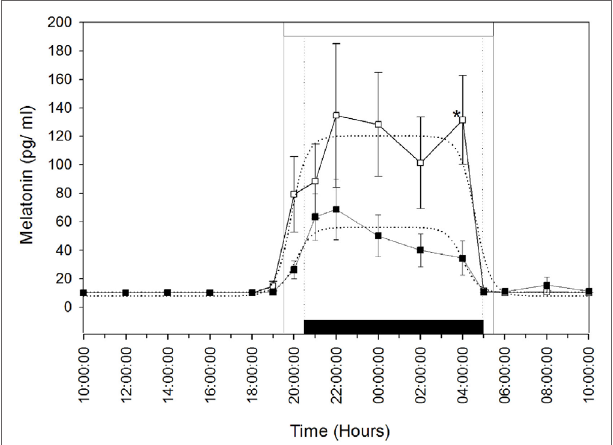
FigUre 2 | Comparison of plasma melatonin concentrations in melatonin-treated group ( ◾ ) and the control group ( ◽ ). (a) Day time plasma melatonin concentrations (mean ± SEM) before and after insertion of melatonin implants. Blood was sampled every week during the day and at the same hour: 10:00. (B) Comparison of 24 h rhythm of plasma melatonin concentrations (mean ± SEM). The blood was sampled during the 28th day after melatonin implants insertion. Bottom white and black bars: durations of the day and the night. The significance levels for differences between treatments (ANOVA) are indicated: * P < 0.05, ** P < 0.01, and *** P < 0.001.